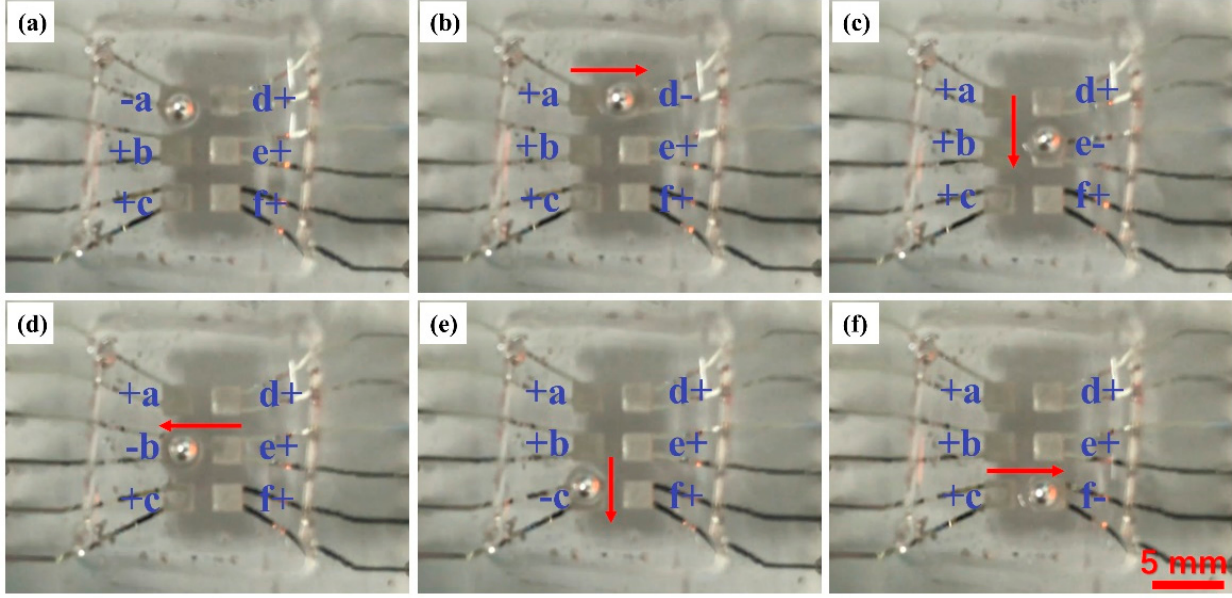
Figure 2. Experimental results for large liquid metal (LM) droplet driving. Six electrodes are numbered as a–d. “+” represents +1000 V, and “ − ” represents − 1000 V. ( a – f ) Droplet position and travelling trace at different electrode conditions.